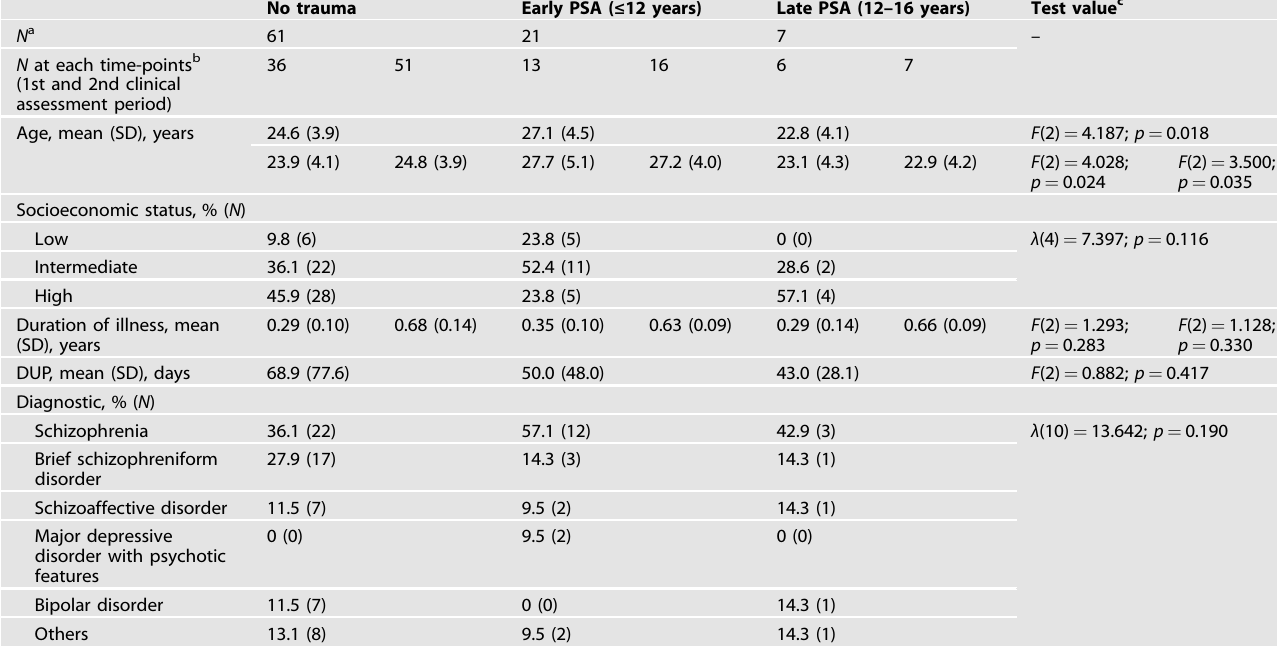
Table 1. Clinical study: demographic table of male early psychosis patients (EPP).